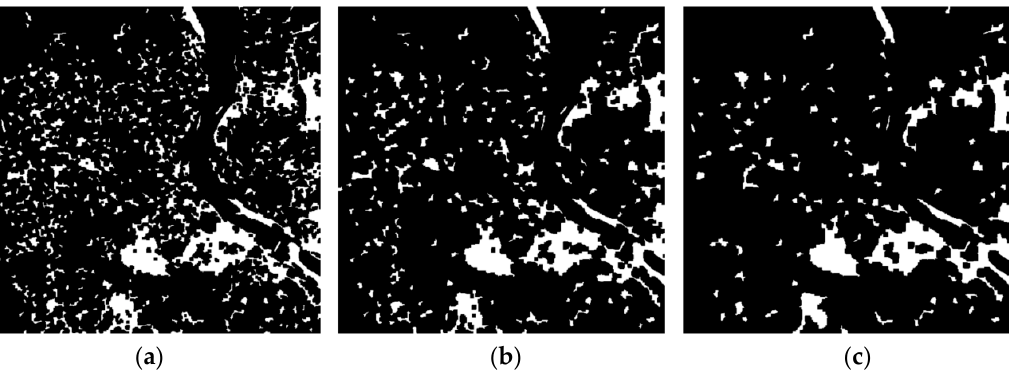
Figure 11. Image differencing results between normalized subject image generated by MS and reference image: ( a ) noise reduction using SLIC 5 × 5; ( b ) noise reduction using SLIC 7 × 7; and ( c ) noise reduction using SLIC 9 × 9.